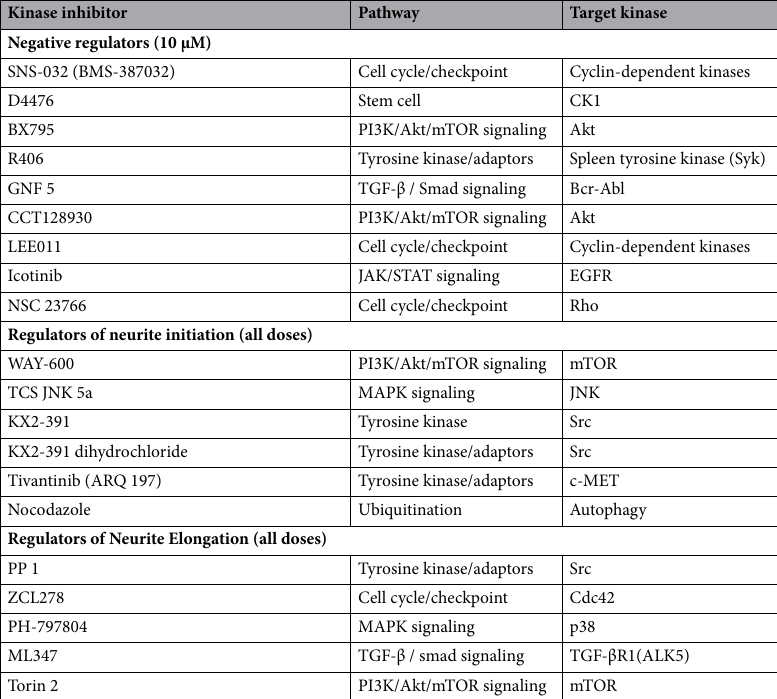
Kinase inhibitor